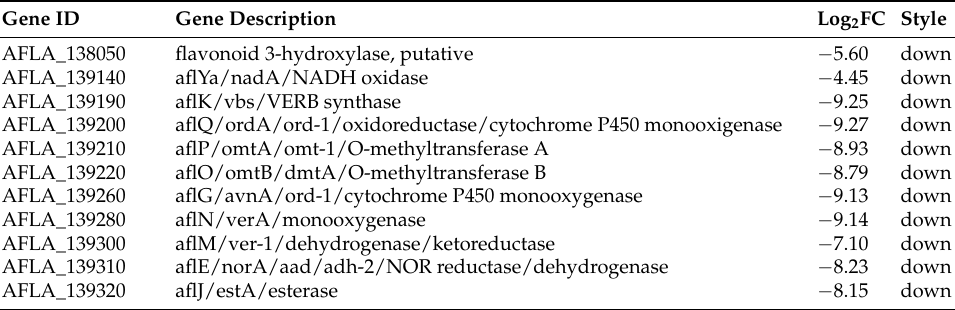
Table 6. Expression profiling of A. flavus genes involved in aflatoxin